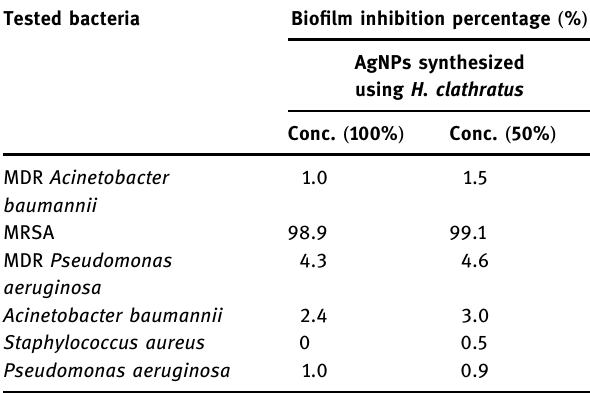
Table 4: Antibio fi lm growth and development activity of AgNP